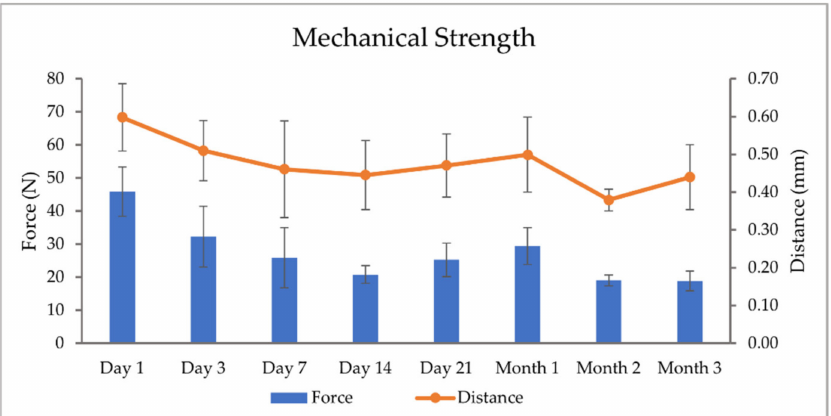
Figure 5. Measured crushing strengths (N) and distance to break (mm) of the ChewTs on the different stability study time points (n =